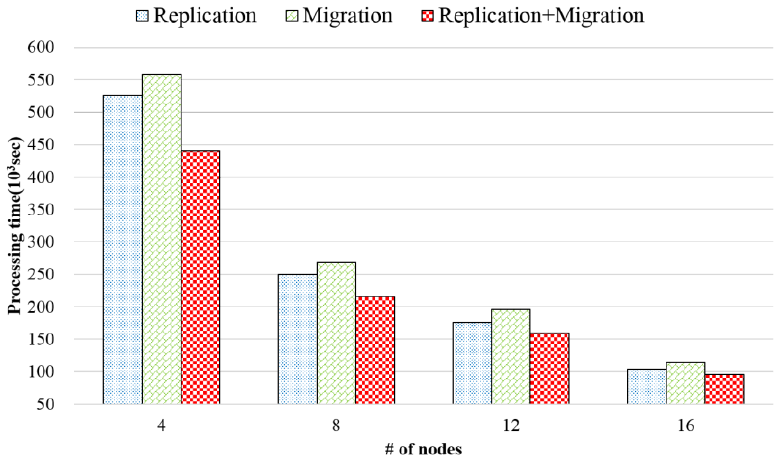
Figure 15. Query processing time according to the number of nodes.